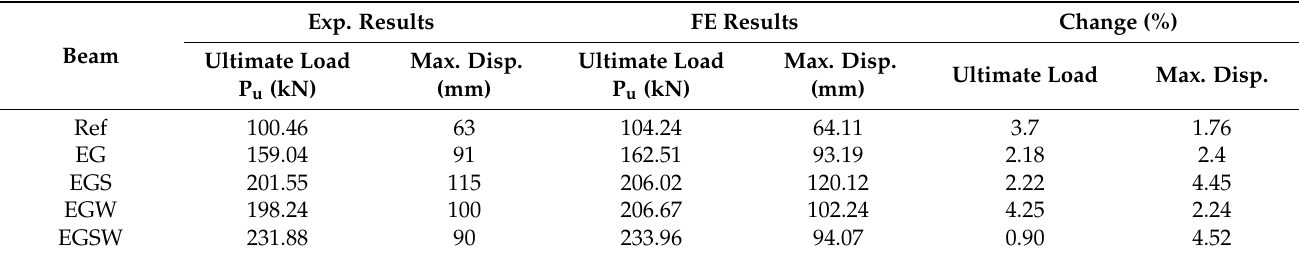
Table 8. Comparison between the FE and experimental results.